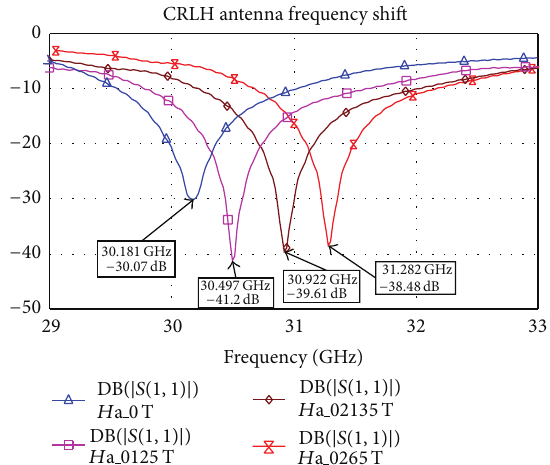
Figure 6: Antenna resonant frequency following the biasing mag- netic field variation.